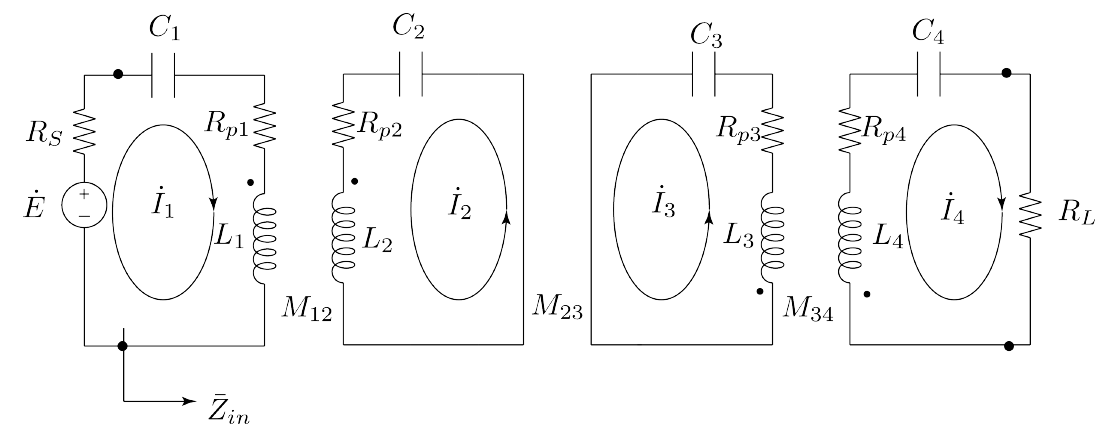
Figure 7. Four-coils Wireless Power Transfer (WPT)